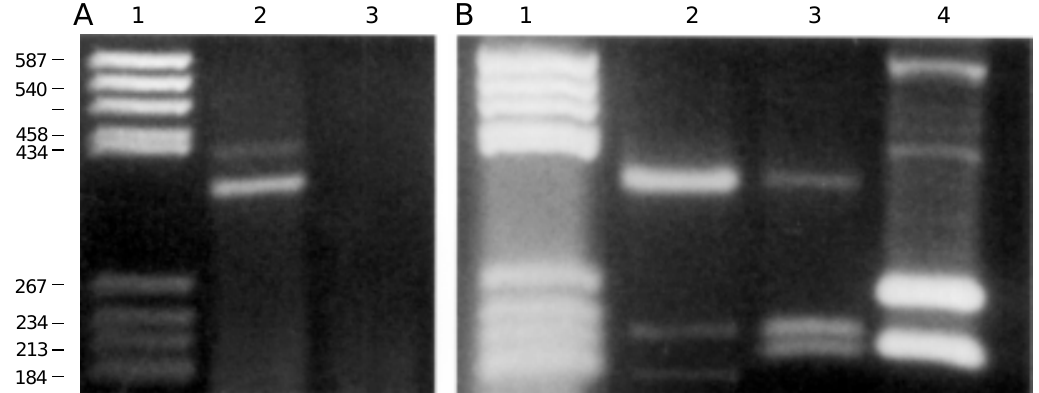
Figure 4 - Determination of the connexin types expressed in rat liver. A , First generation of PCR products indicates that the amplified DNA sequences belong to groups I and II (lane 2), as expected, and its corresponding negative control (lane 3). Molecular markers (lane 1). B , Second generation of PCR products. For this figure, first round PCR bands were isolated from the gel and PCR products belonging to Cx26 (lane 2), Cx32 (lane 3) and Cx43 (lane 4) were identified, as expected. Molecular markers (lane 1). The endonucleases used were Mse I (Cx26; lane 2), Eco NI (Cx32; lane 3) and Hin cII (Cx43; lane